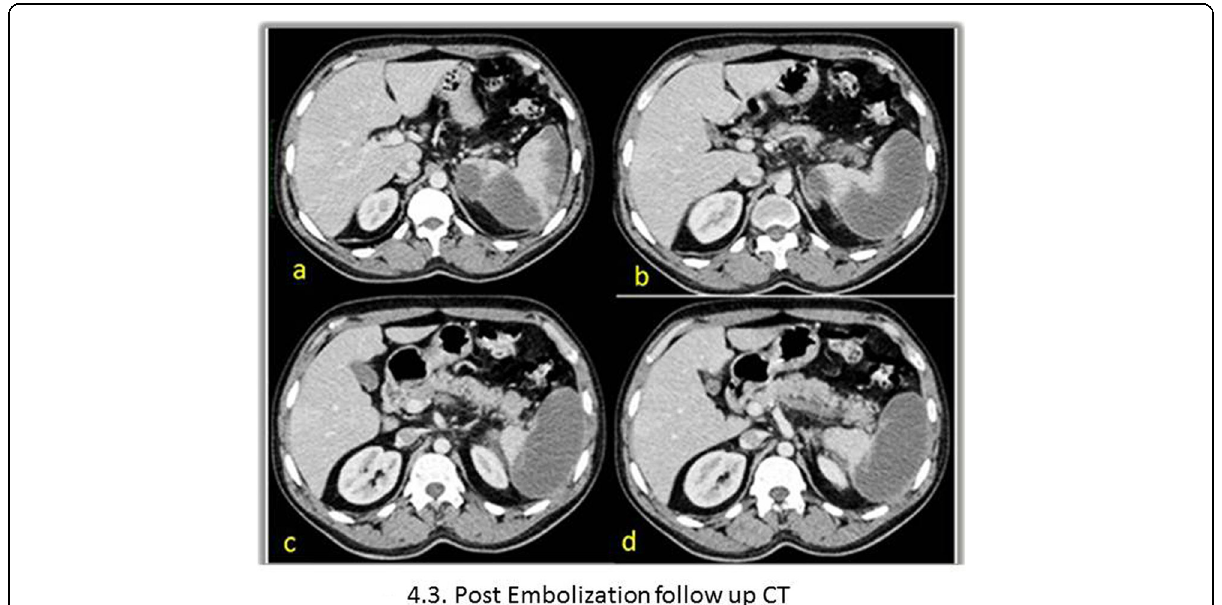
Fig. 9 Post-embolization follow-up CT examination. a – d Multiple axial cuts at the portovenous phase revealed multiple hypodense areas of near fluid density seen involving most of splenic parenchyma with mainly peripheral distribution, denoting post-embolization multiple